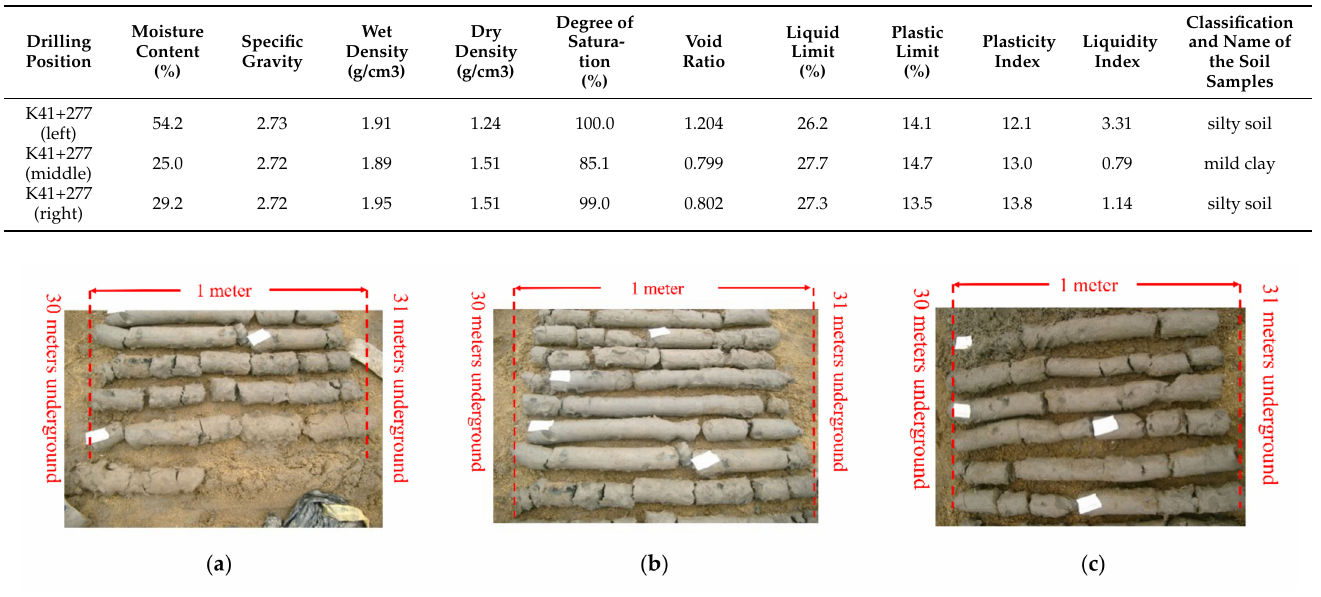
Figure 4. Samples from the left, middle, and right positions of soft soil foundation in the coastal area of South China section K41+277 of the expressway: ( a ) K41 + 277 left; ( b ) K41 + 277 middle; and ( c ) K41 + 277 right.